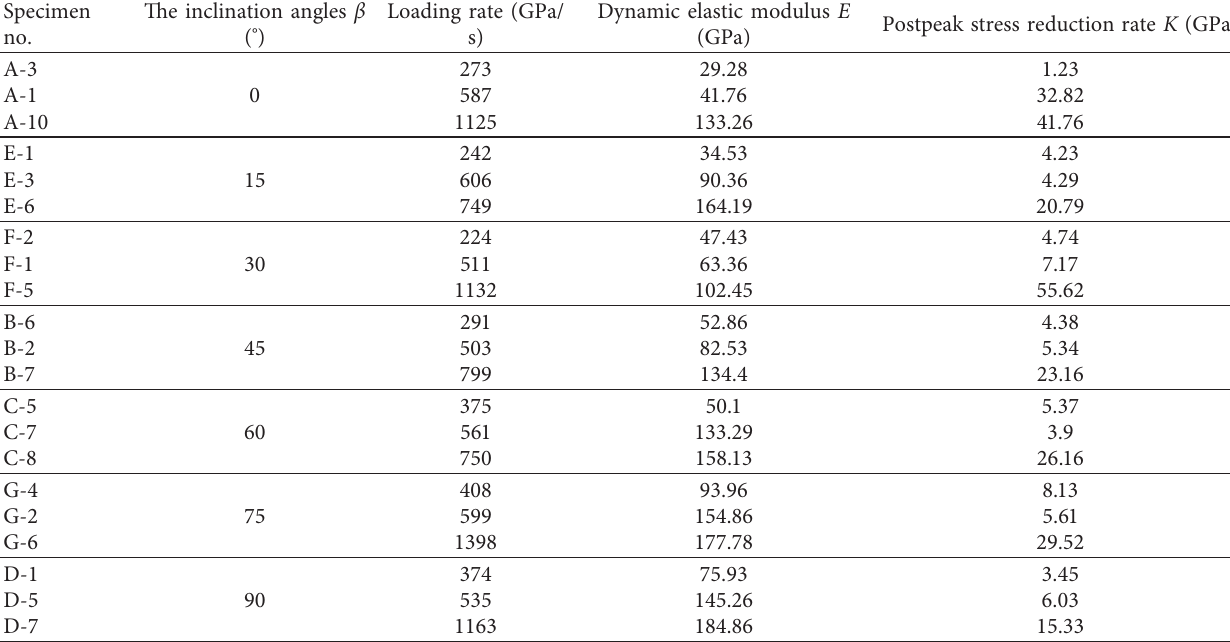
Table 1: Dynamic elastic modulus E and postpeak stress reduction rate K .